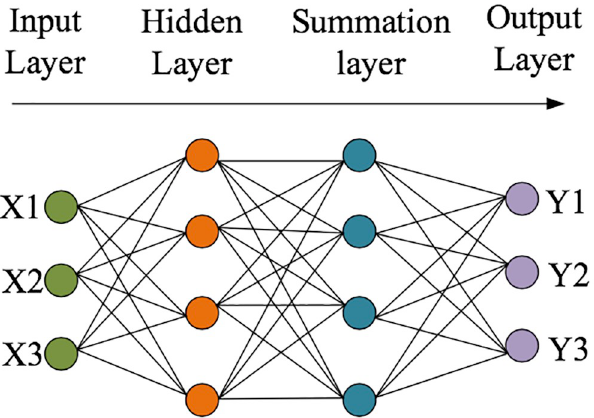
Fig 4. Schematic diagram of the GRNN neural